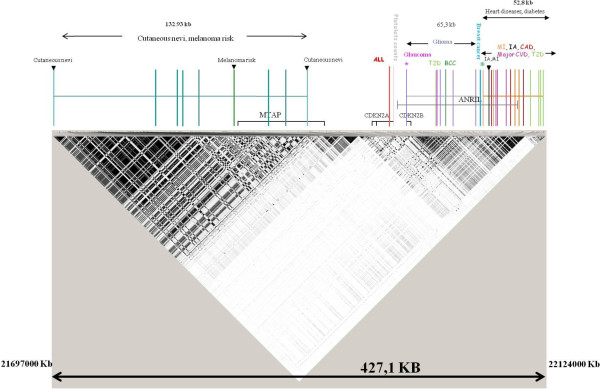
Linkage disequilibrium map of chromosome 9p21 from 21697000 bp to 22124000 bp. The map derived from HapMap (release #27) shows the SNPs associated in GWAS with several cancers including melanoma and other diseases. T2D Type II diabetes, MI myocardialinfarction, CVD cardiovascular disease, CAD coronary artery disease, BCC Basal cell carcinoma, IA Intracranial aneurism, ALL Acute lymphoblastic leukemia.